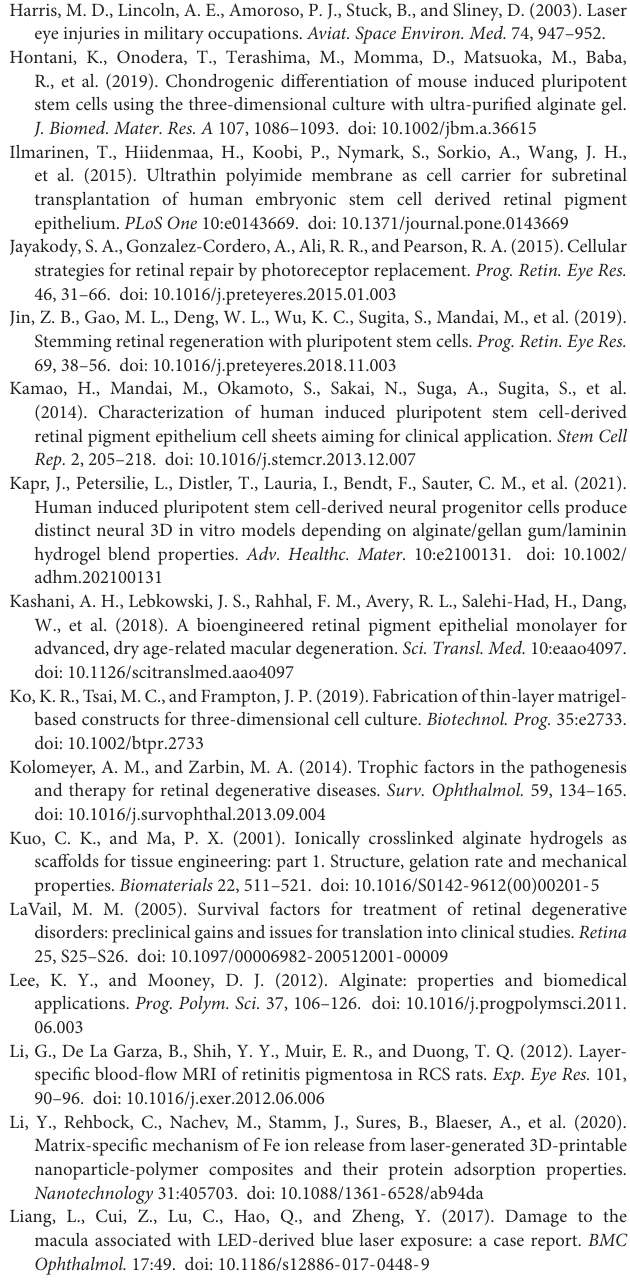
Supplementary Figure 1 | Staining for RPE-marker RPE-65 (green) and CRX (cone-rod homeodomain transcription factor, marker for photoreceptor progenitors and later cone bipolar cells). (A,B) Transplant #1, 176 dps (age 228 days). The space in the section and the lifting of the parylene is created by a processing artifact. The transplant RPE is stained for